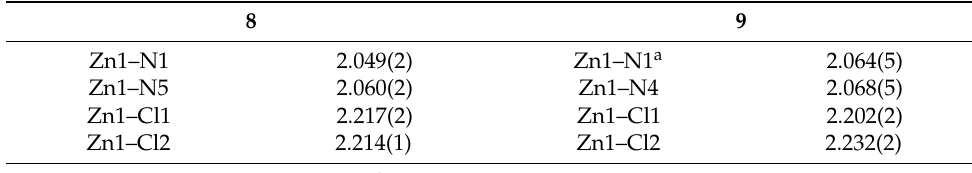
Table 6. Selected bond lengths (Å) for compounds 8 and 9 .